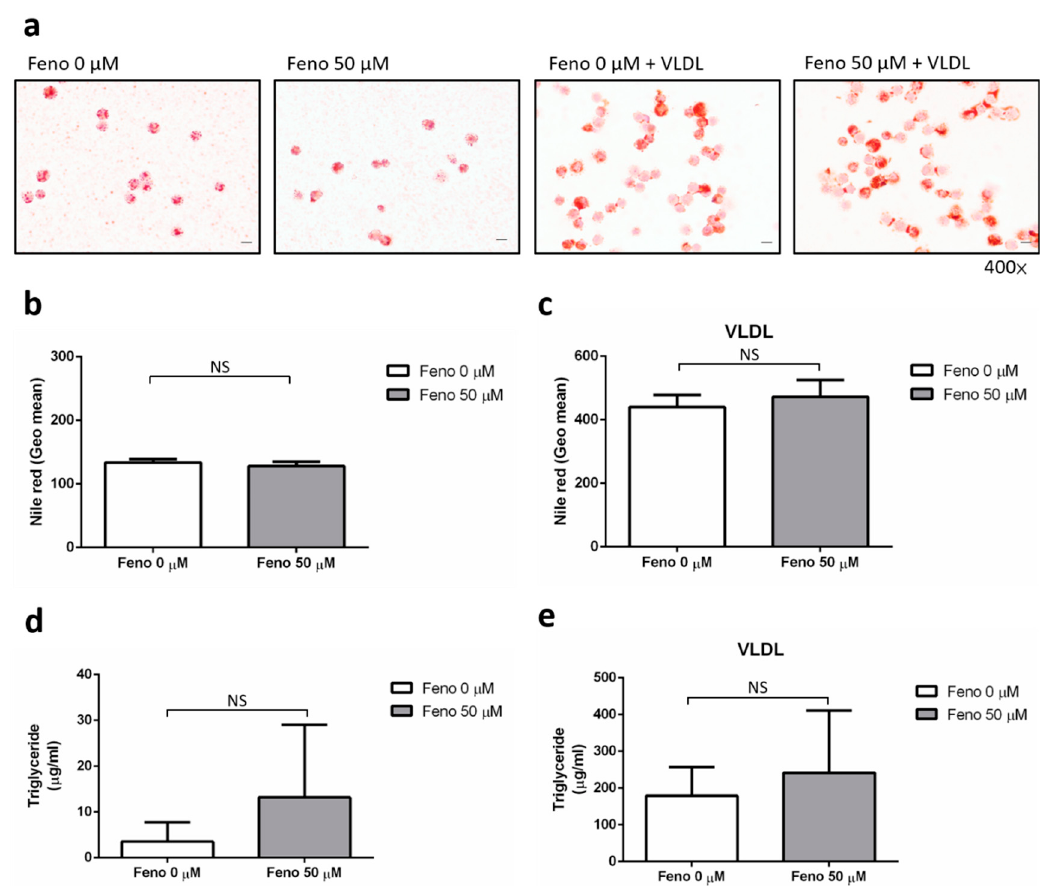
Figure 2. The effect of fenofibrate with/without very low-density lipoprotein (VLDL) on lipid accumulation in human macrophages. ( a ) Human macrophages were stained with Oil Red O and observed by light microscopy on day 2 (400× magnification). ( b , c ) For detection of lipid droplets, human macrophages, treated with/without fenofibrate or VLDL, were infected with mycobacteria, stained with Nile Red, and analyzed by flow cytometry ( n = 15). Lipid accumulation represented as the geometric mean. ( d , e ) Quantification of intracellular triglycerides in human macrophages ( n = 3). Scale bars represent 10 µm. Data are shown as means ± SEMs and were analyzed using an unpaired t- test. NS: Not Significant.